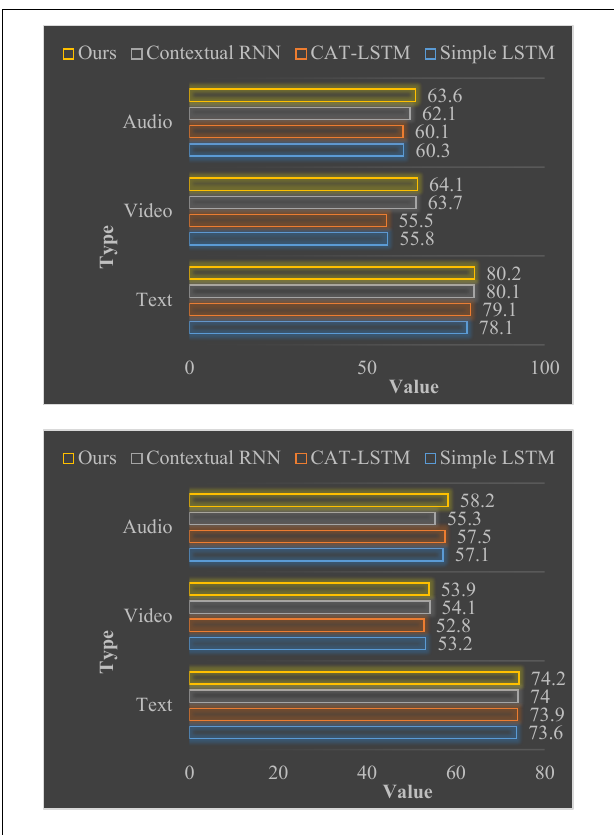
FIGURE 6 | The accuracy of single-modal emotion analysis in MOSI and MOSEI, respectively.